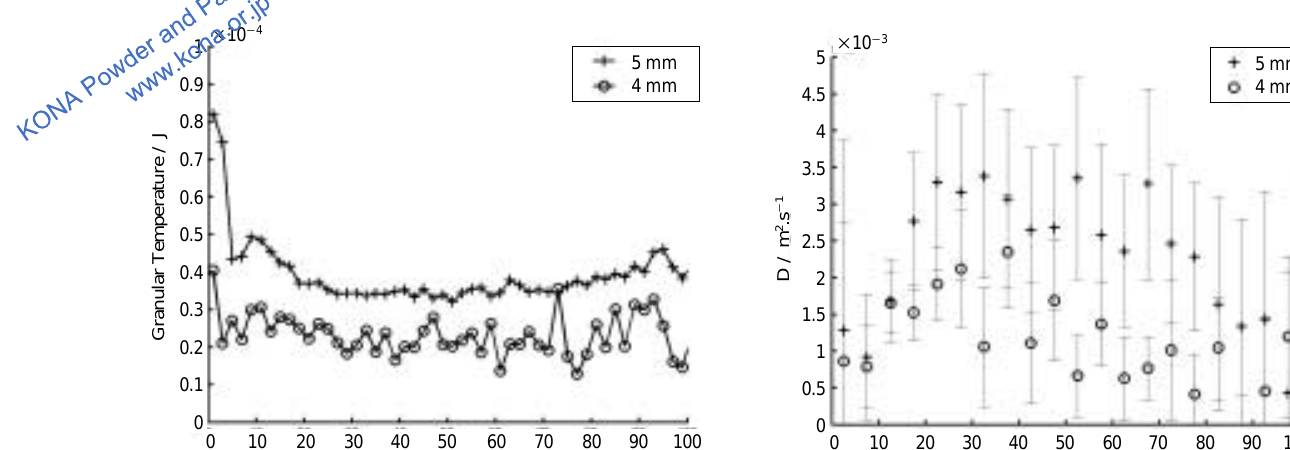
ferent solids distribution profiles for each phase, resulting in significantly different collision rates and dissipation rates. This has the effect that the particles relax towards different granular temperatures, which are coupled through the inter-phase particle colli- sions. The differences in the granular temperature and packing fraction propagate in turn due to differ- ences in the diffusion coefficients.